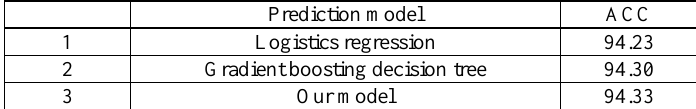
Table 2. Comparison of prediction